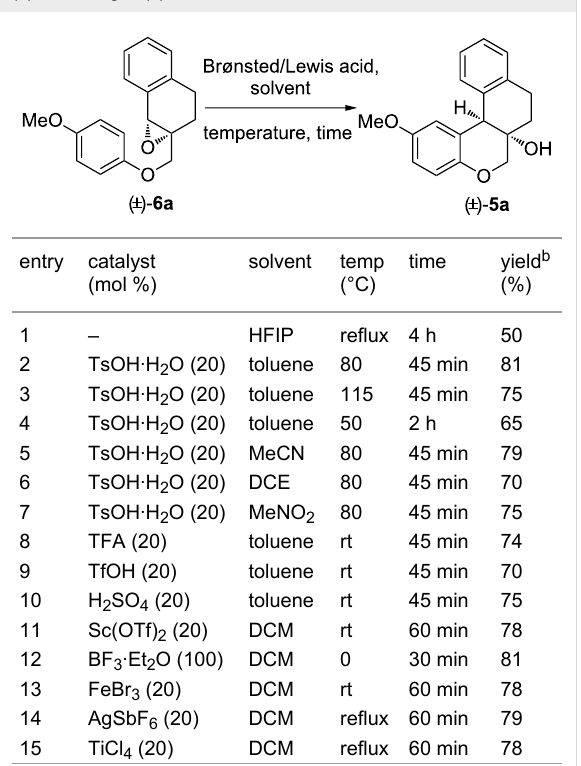
Table 1: Screening of reaction conditions on the IFCEA cyclization of (±)- 6a leading to (±)- 5a a